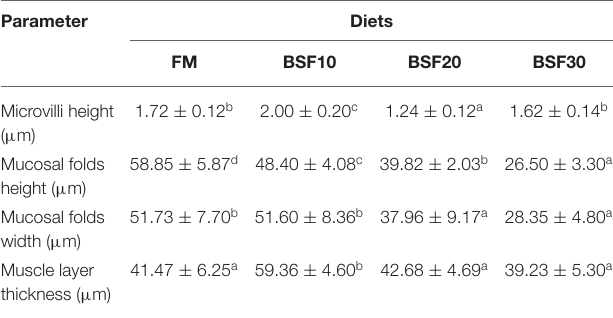
TABLE 5 | The effect of black soldier fly larvae meal (BSF) on growth performance of Litopenaeus vannamei . Parameter Group